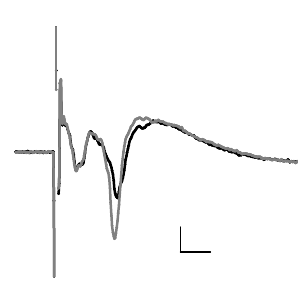
Figure 2 | The averaged fi eld potential ( n = 20 responses) before and after application of CRF (0.1 μ M). The black trace = baseline, grey trace = after drug; horizontal scale bars 2 ms, vertical 0.2